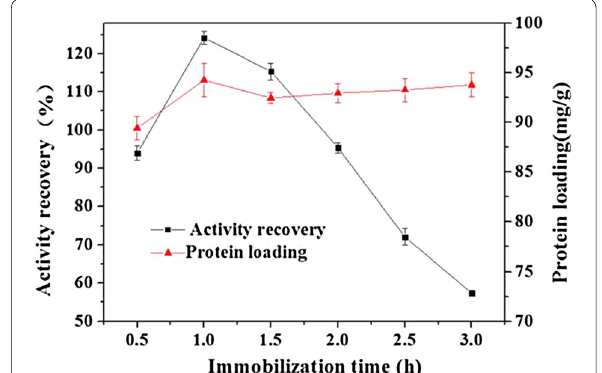
Fig. 5 Effects of buffer pH on activity recovery and enzyme loading of immobilized GOx